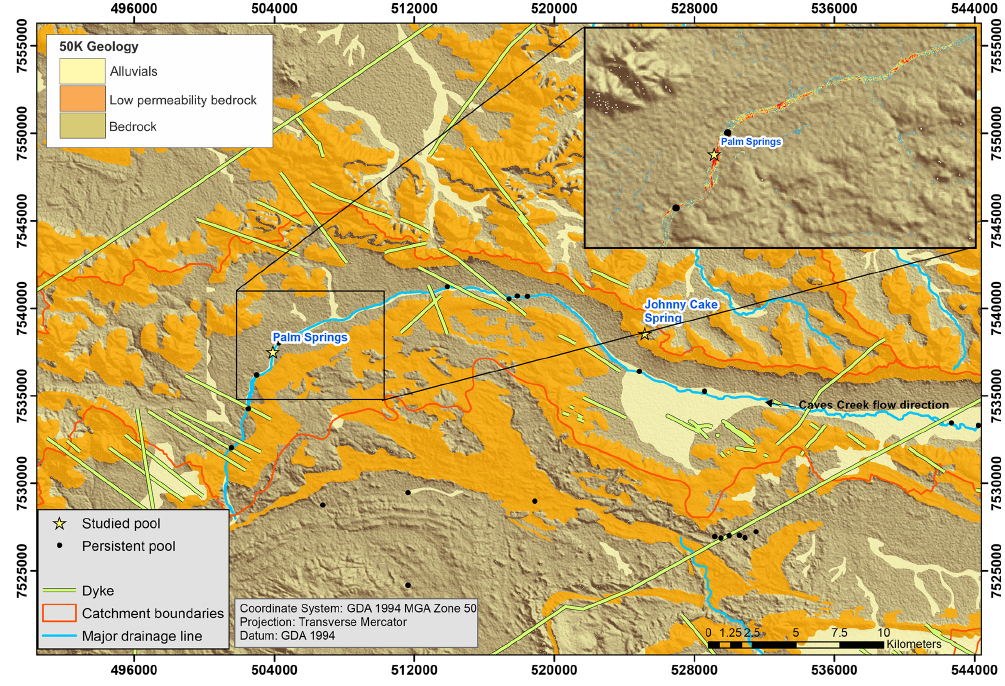
Figure 7. Map showing locations of persistent pools along Caves Creek relative to bedrock, low-permeability bedrock, dikes, and alluvial river-channel sediments (geological mapping 50K). Inset shows NDVI (on a scale of 0 in blue to 100 in red).